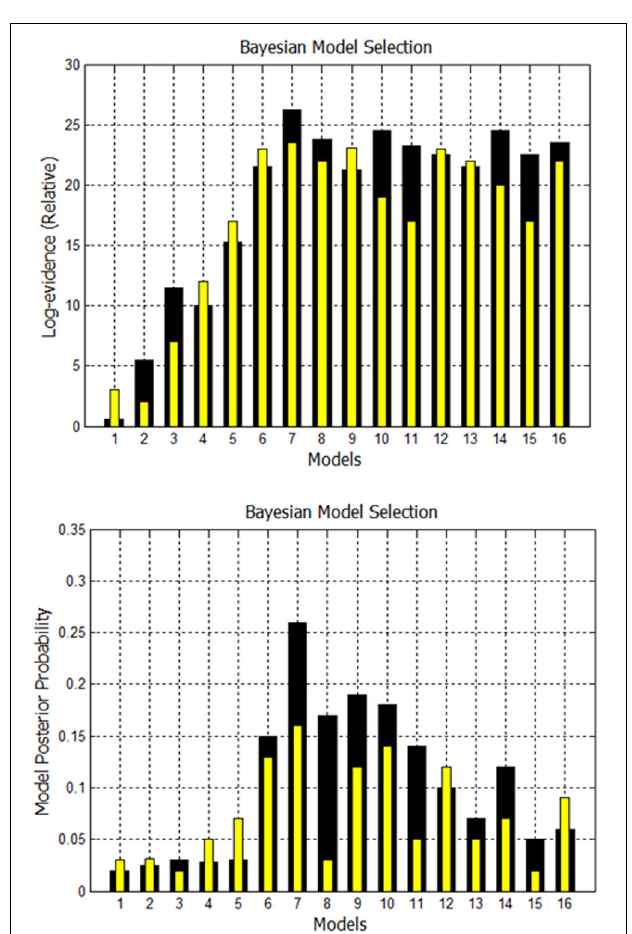
FIGURE 10 | Comparison of FFX Analysis for Simon task dataset for two techniques. Black bars are for estimation of missing nodes with EM. Yellow bars are for using the higher p -values to get the missing nodes. Model 7 has the highest evidence in both cases for this